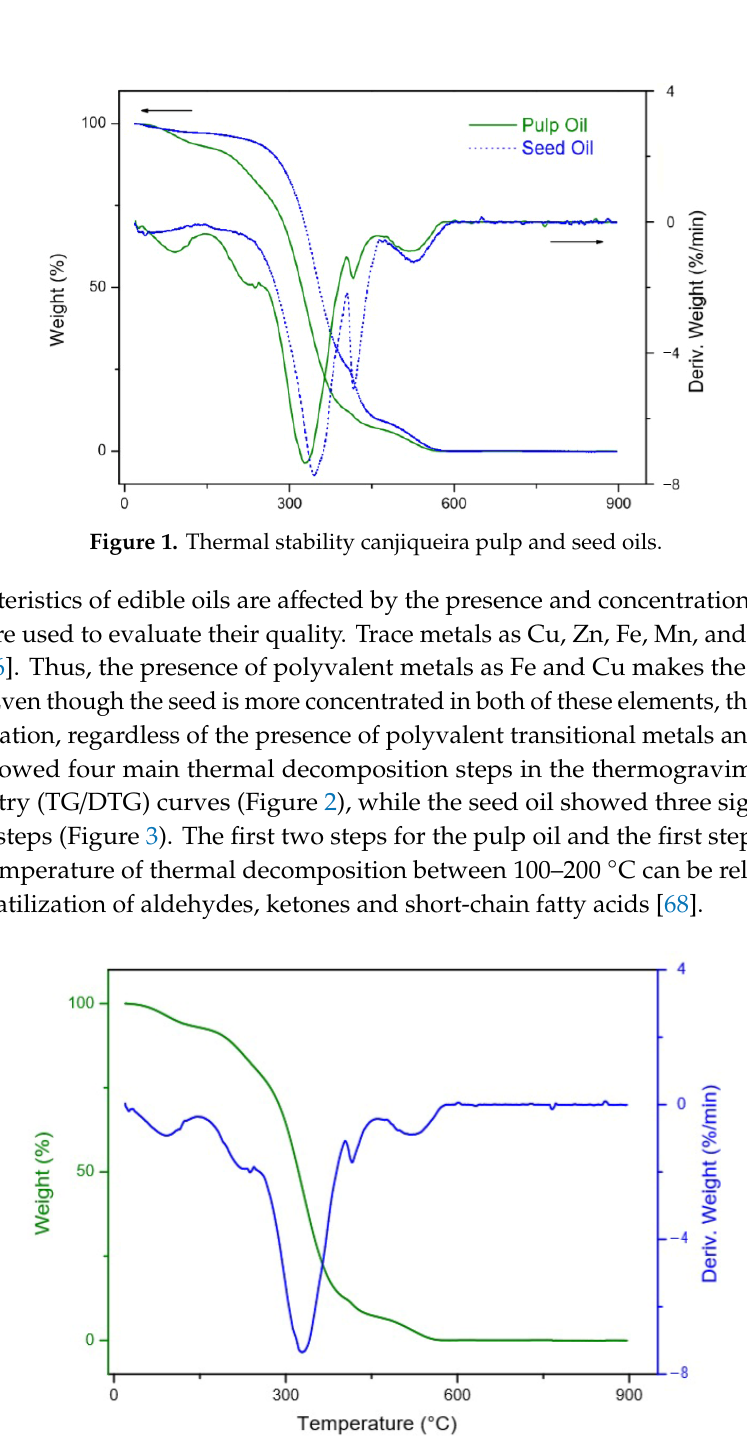
Figure 2. Thermal decomposition of canjiqueira pulp oil.